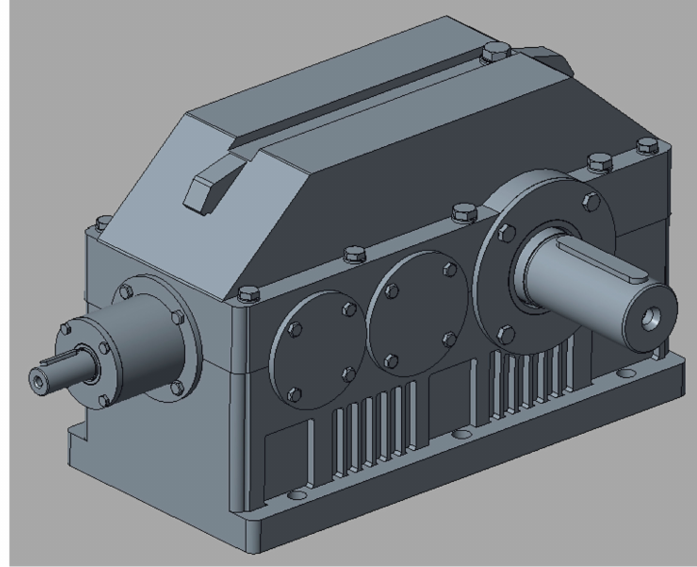
Figure 2. The total assembly of the gearbox.